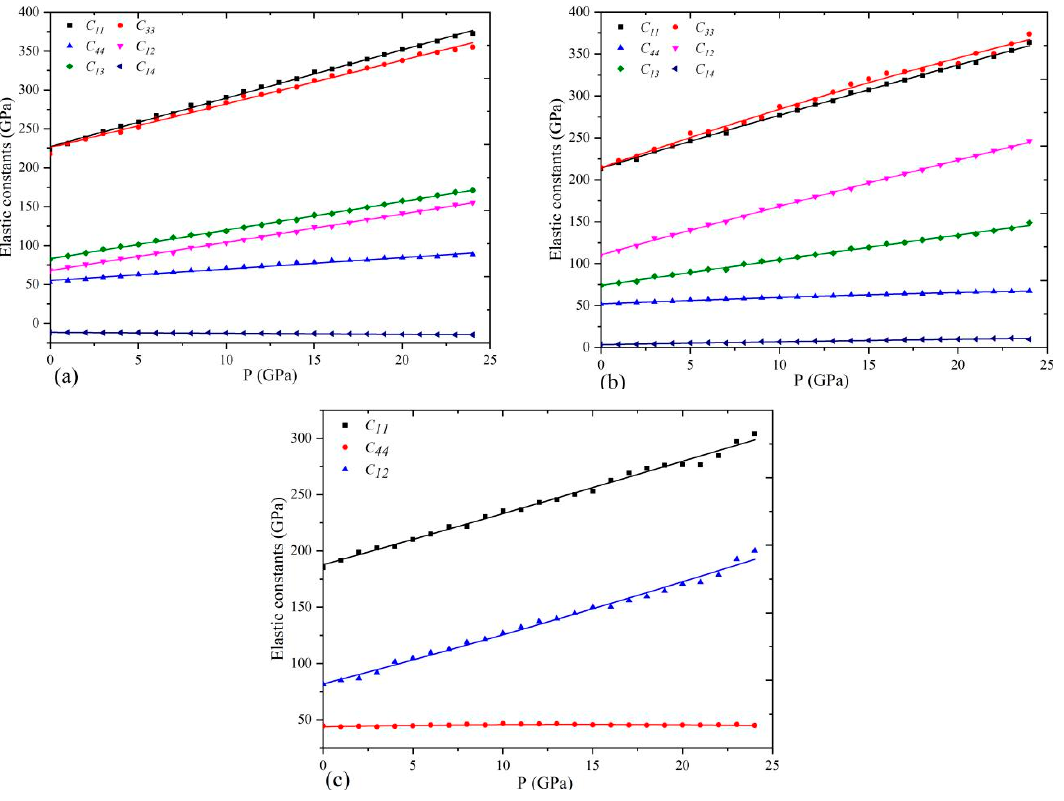
Figure 3. Elastic constants of Ni sulfides as a function of pressure. ( a ) millerite; ( b ) heazlewoodite; ( c ) polydymite.